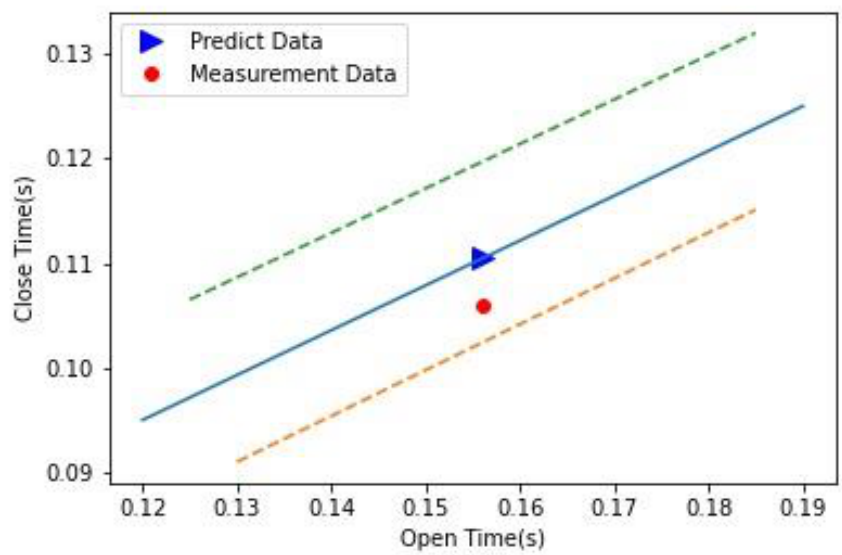
Figure 12. Linear regression model.